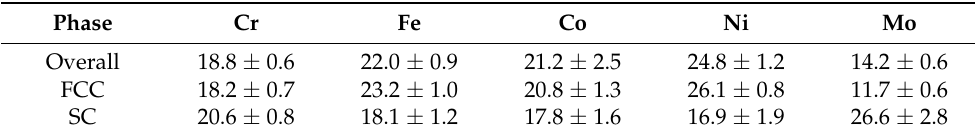
Figure 1. ( a ) A micrograph and ( b ) XRD pattern of as-cast Cr 19 Fe 22 Co 21 Ni 25 Mo 13 alloy. Table 1. Chemical compositions of as-cast Cr 19 Fe 22 Co 21 Ni 25 Mo 13 alloy in atomic percent analyzed by SEM/EDS.